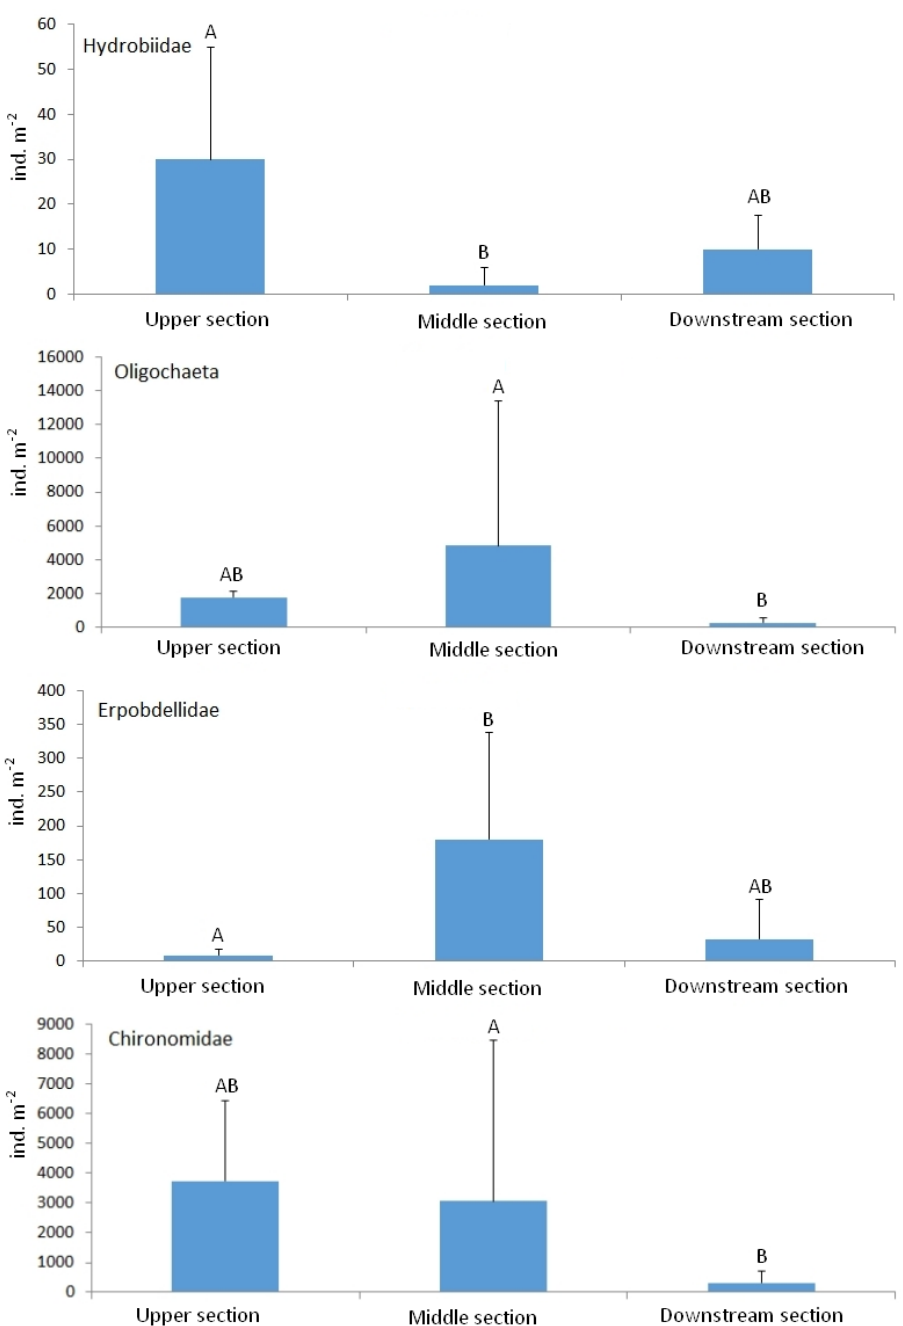
Figure 7. The significant di ff erences between stream sections in abundance of Hydrobiidae, Oligochaeta, Erpobdellidae, and Chironomidae. The di ff erent letters on the columns show significant di ff erences between sections ( p <